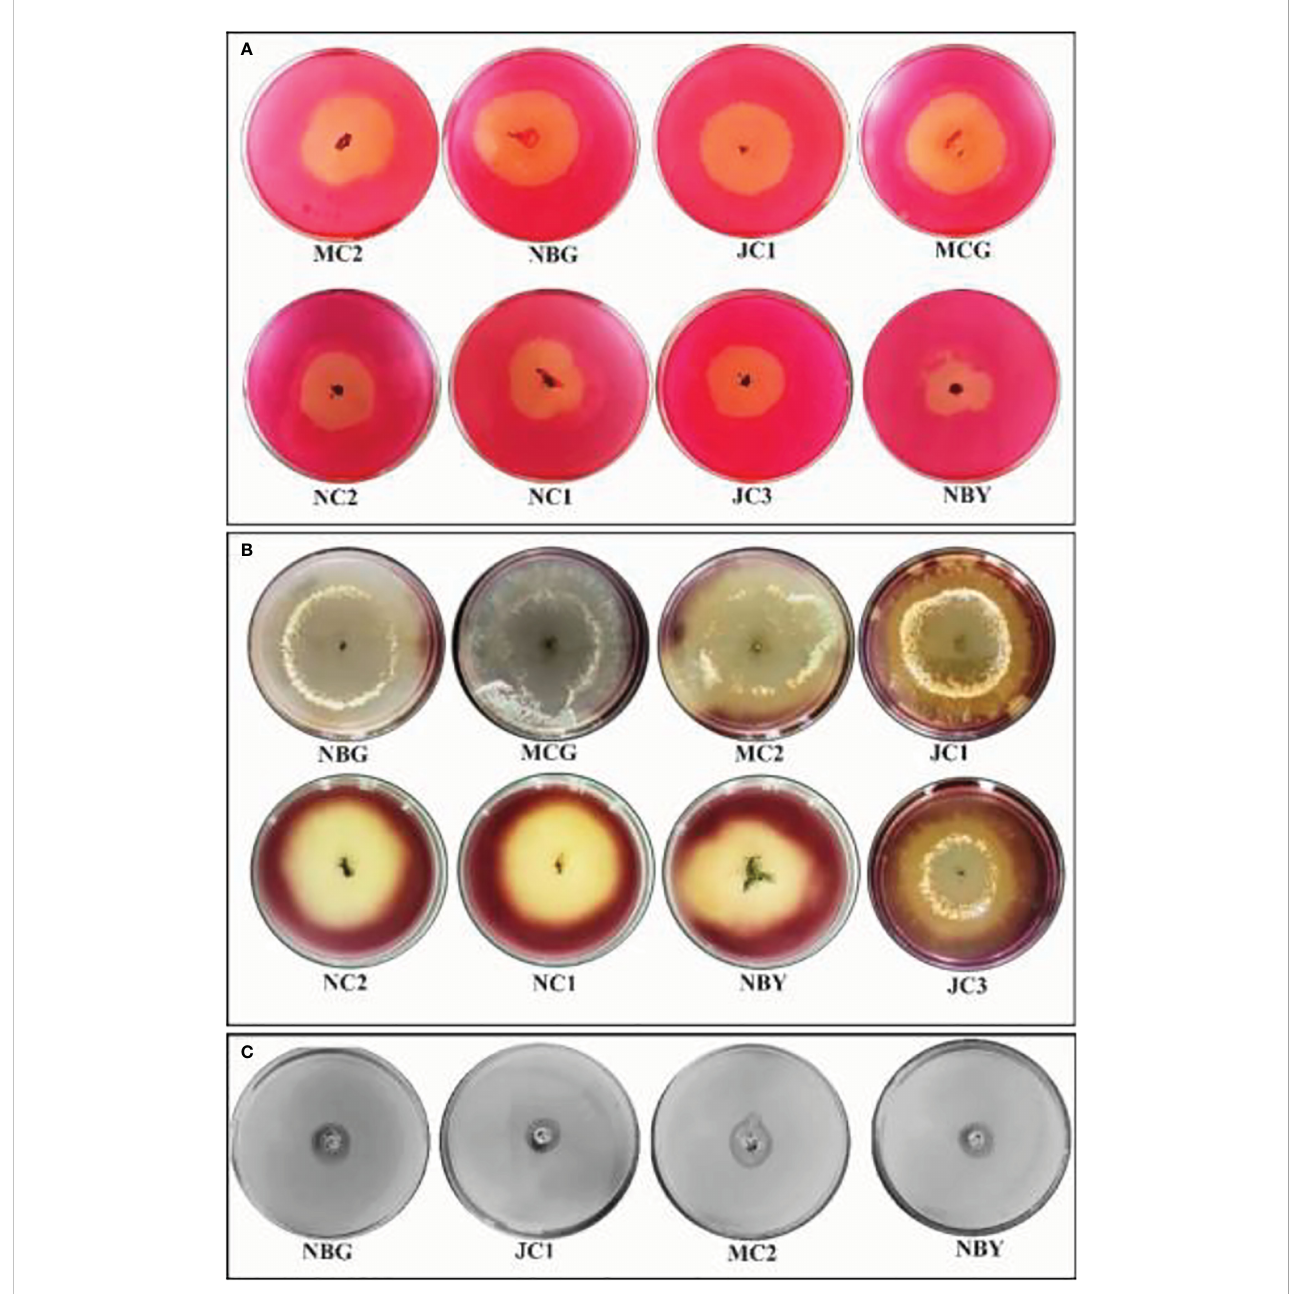
FIGURE 8 Zonations of fungal microbial colonies in qualitative plate assay showing the release of cellulase, amylase, and protease enzyme by rhizospheric isolates. (A) Cellulase (B) Amylase (C)